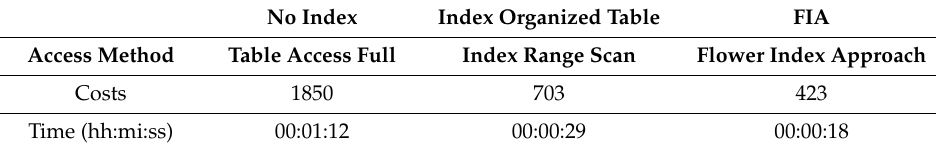
Table 3. Index processing—costs and time demand—the presence of the secondary indexes.